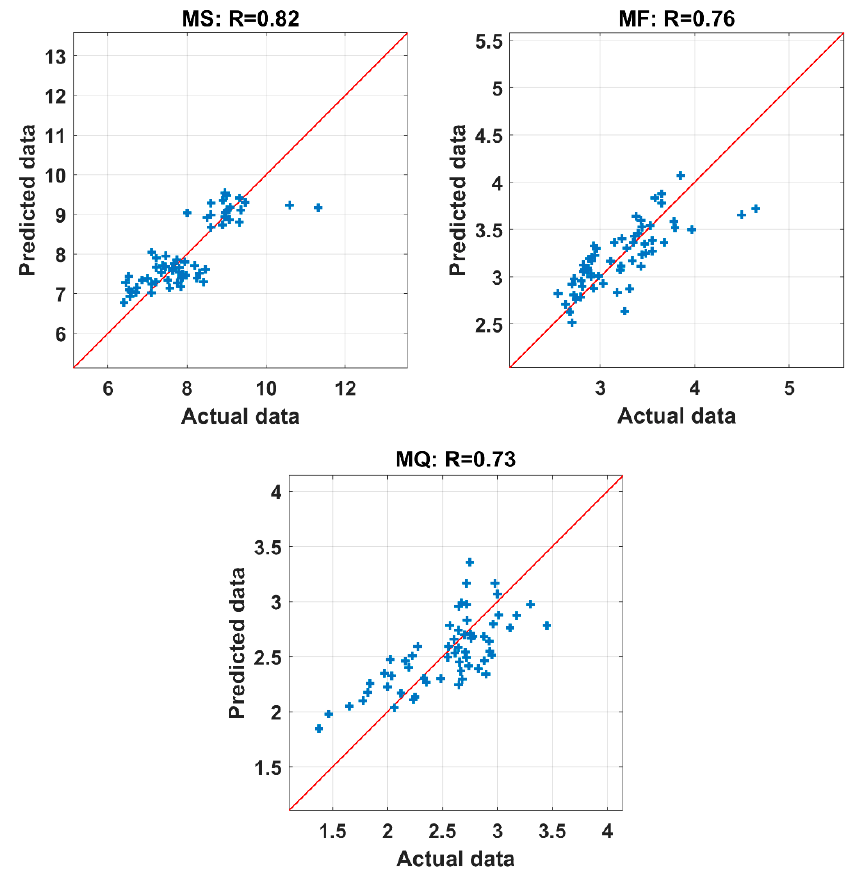
Figure 10. Correlation coefficient of the regression of the actual and predicted values.